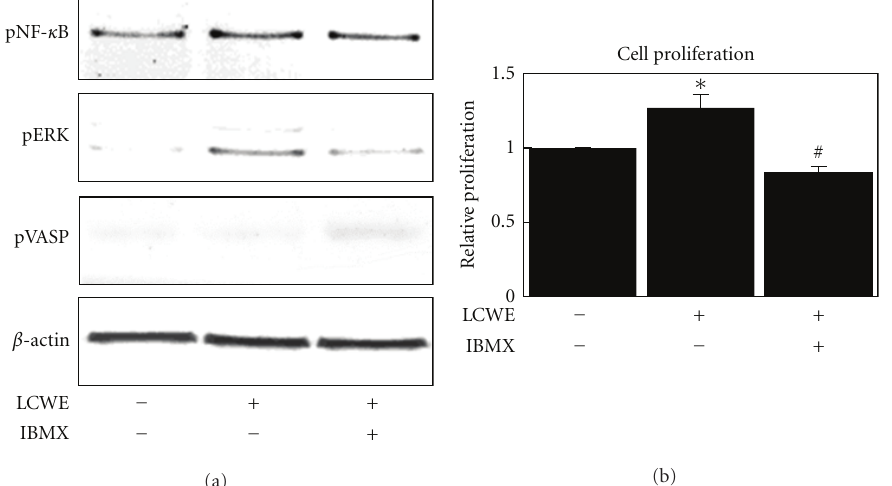
Figure 3: Changes in the levels of phospho-NF- κ B, phospho-ERK, and phospho-VASP (a) and change in cell proliferation (b) in NIH3T3 mouse fibroblast cells after treatment with LCWE (10 μ g/mL) or a combination of IBMX (1 μ M) and LCWE (10 μ g/mL). Each column represents the mean ± SEM. ∗ P < 0 . 01 versus untreated controls. # P < 0 . 01 versus LCWE treatment